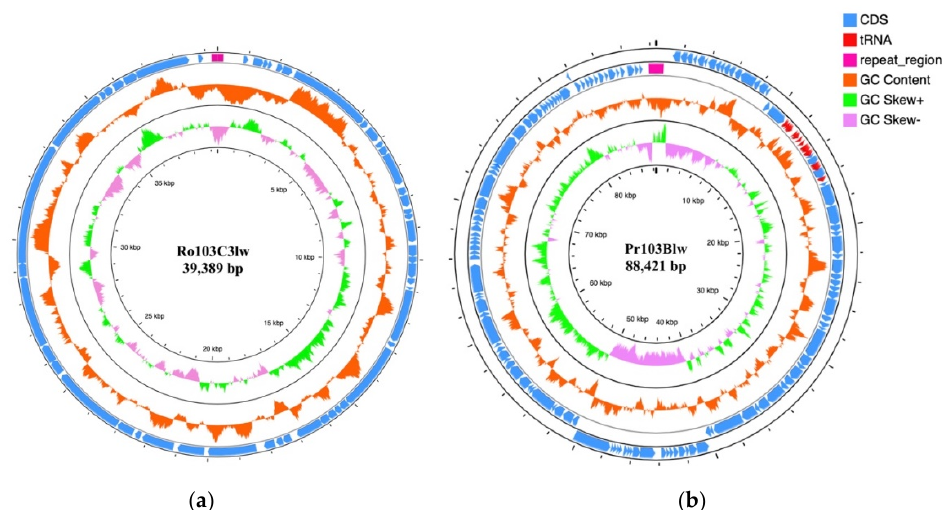
Figure 4. Circular genome maps of phage Ro103C3lw ( a ) and Pr103Blw ( b ) using CGview server BETA . The rings from inside out represent GC skew (green and light purple), GC content (orange), CDSs (blue), and repeat region (velvet). tRNAs (red) are only detected in phage Ro103Blw ( b ). The predicted functions of the annotated CDSs are listed in Tables S1 and S2.